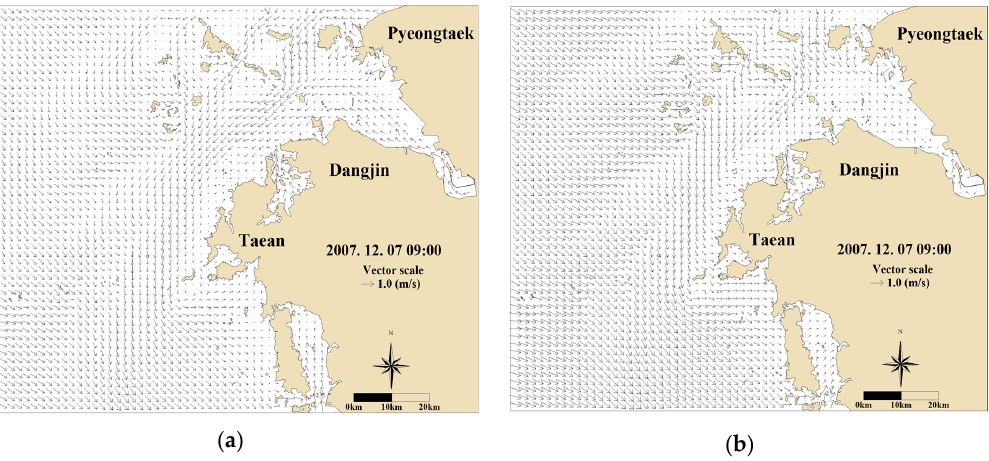
Figure 14. Surface layer snapshot of the tidal currents at 9 a.m., on 1 December 2007: ( a ) current velocity vector of Case 1 and ( b ) current velocity vector of Case 2.